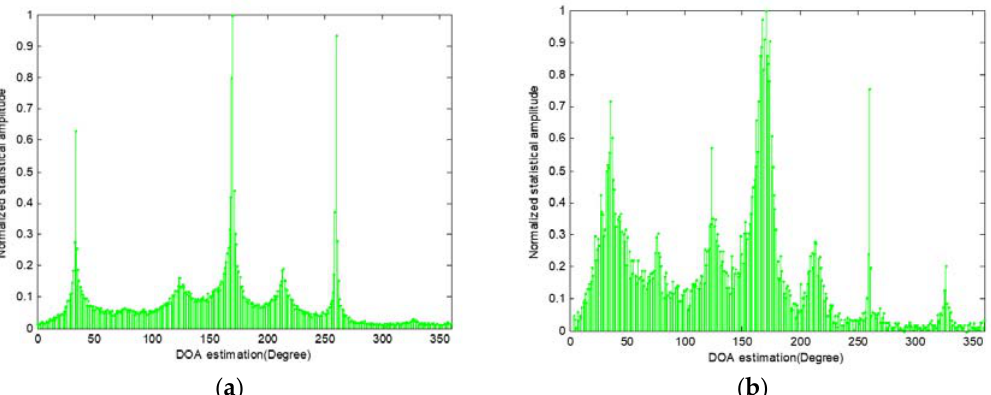
Figure 6. Normalized amplitude histogram of seven sources ( a ) DOA estimation exploit SSZ-based method; ( b ) DOA estimation exploit SDSCR algorithm.